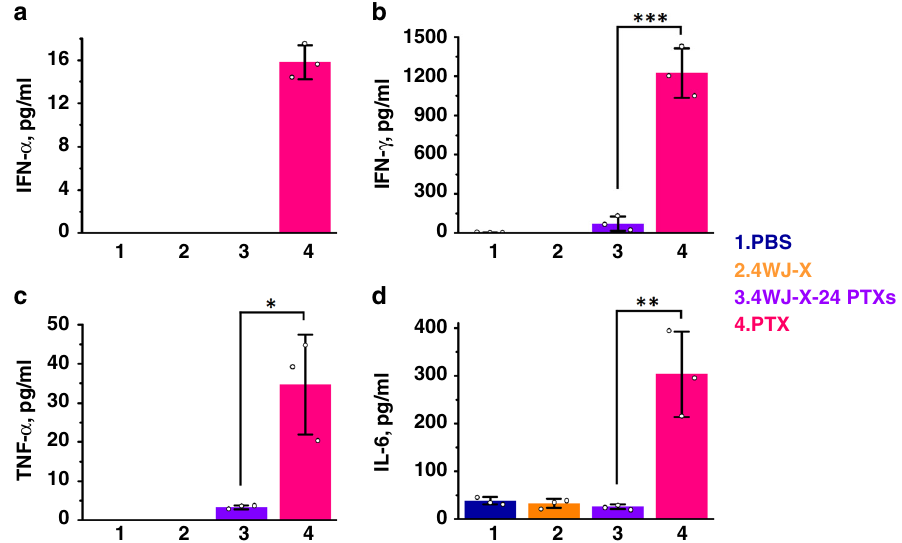
Fig. 7 In vivo immunostimulation study of 4WJ-X-24 PTXs nanoparticles. Evaluation of a IFN- α , b IFN- γ , c TNF- α , and d IL-6 secretion in mice after systemic injection of 4WJ-X-24 PTXs nanoparticles, evaluated by enzyme-linked immunosorbent assay (ELISA) ( n = 3 biologically independent animals, statistics was calculated by two-tailed unpaired t-test presented as mean ± SD, p = 5.4 × 10 − 4 , 0.013, and 5.9 × 10 − 3 comparing 4WJ-X-24 PTXs to PTX for IFN- γ , TNF- α , and IL-6, respectively). Source data are provided as a Source Data fi chemokines such as C10, complement C5/C5a, and MIP-1 α injection (Supplementary Fig. 12). These results suggest that 4WJ- showed elevated induction compared with the PBS group, indi- X-24 PTXs nanoparticles exhibited good biocompatibility and no cating the nanoparticles might partially trigger some mediators ’ negative effects on important organs in vivo. Overall, it is con- secretion. The histological study indicates that no organ damage cluded that 4WJ-X-24 PTXs nanoparticles did not trigger was caused by 4WJ-X-24 PTXs nanoparticles after systemic immune responses compared with the Cremophor EL formulated